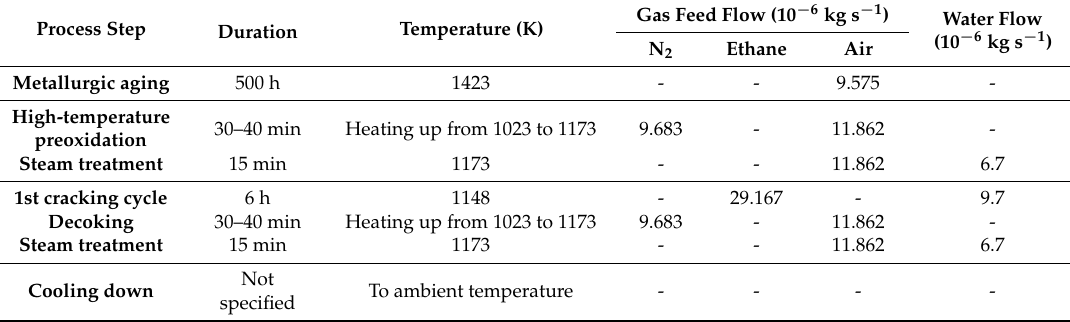
Table 2. Procedure of metallurgic aging followed by a single coking-decoking cycle.